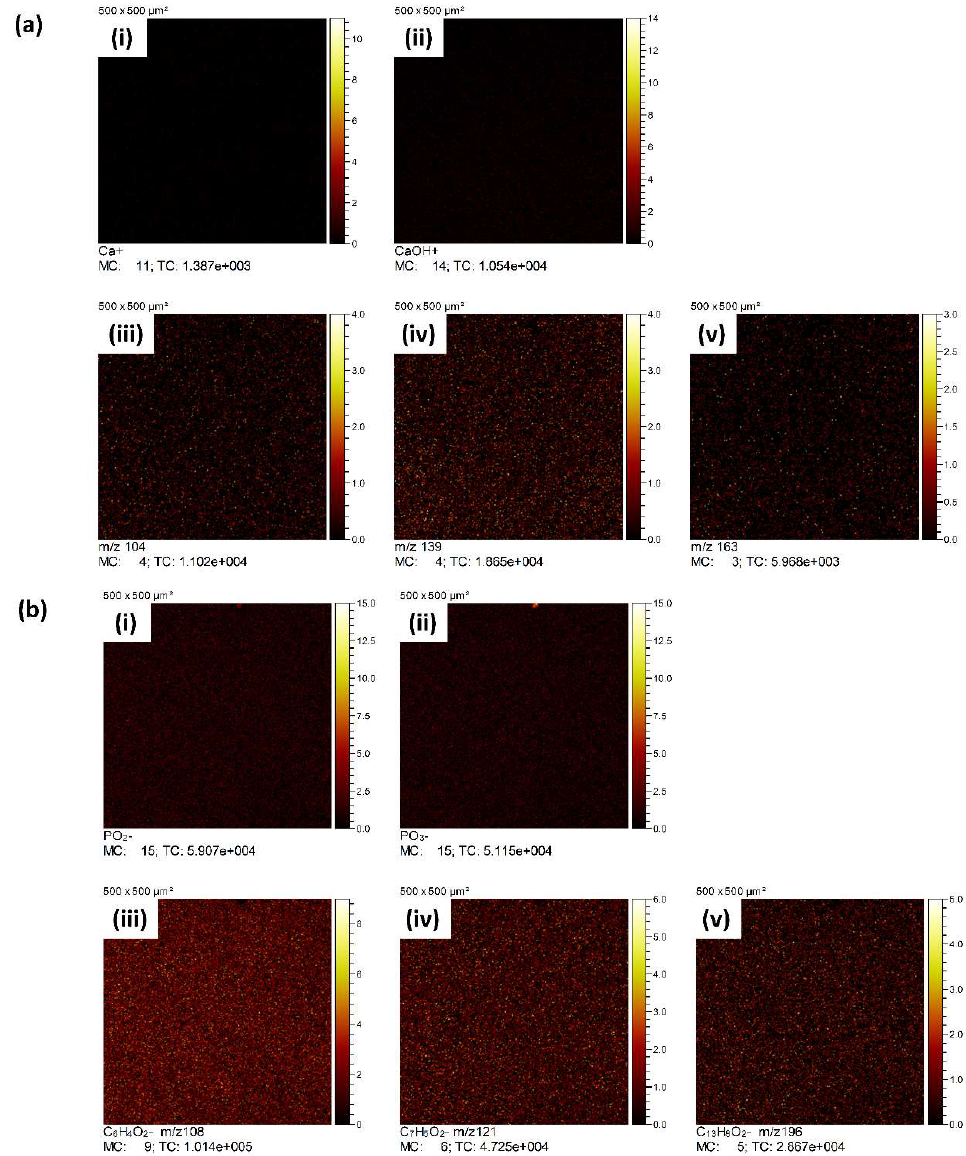
Figure 10. ( a ). ToFSIMS positive ion intensity surface maps for PEEK obtained at selected masses